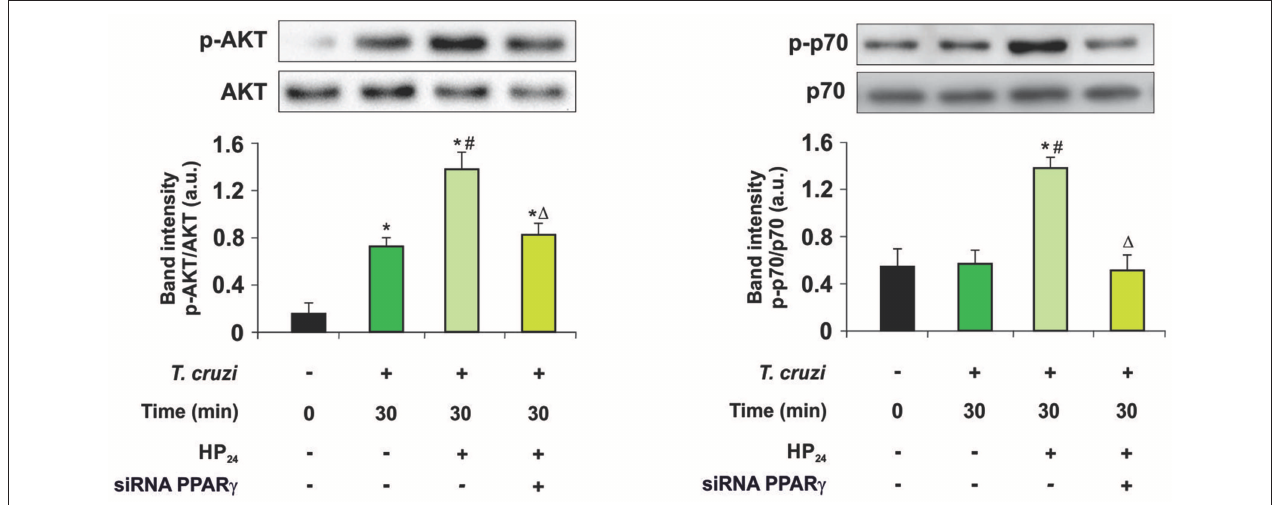
FIGURE 4 | PPAR γ is required for the HP 24 effects on PI3K/AKT/mTOR signaling pathway. Peritoneal macrophages were obtained and transfected with PPAR γ -siRNA during 72h. Transfected or non-transfected cells were treated with HP 24 (100 µ M) since 30min before infection. Then, these cells were infected with T. cruzi for 30min (parasite:cell ratio 5:1). Western blot analyses were carried out in cytosolic extracts, and p-AKT (Ser 473)/total AKT and p-p70 (Ser 411)/total p70 expression was analyzed. Results represent the mean ± SEM of three independent experiments. * P < 0.05 vs. uninfected cells, # P < 0.05 vs. T. cruzi -infected cells. 1 P < 0.05 vs. T. cruzi -infected and HP 24 -treated